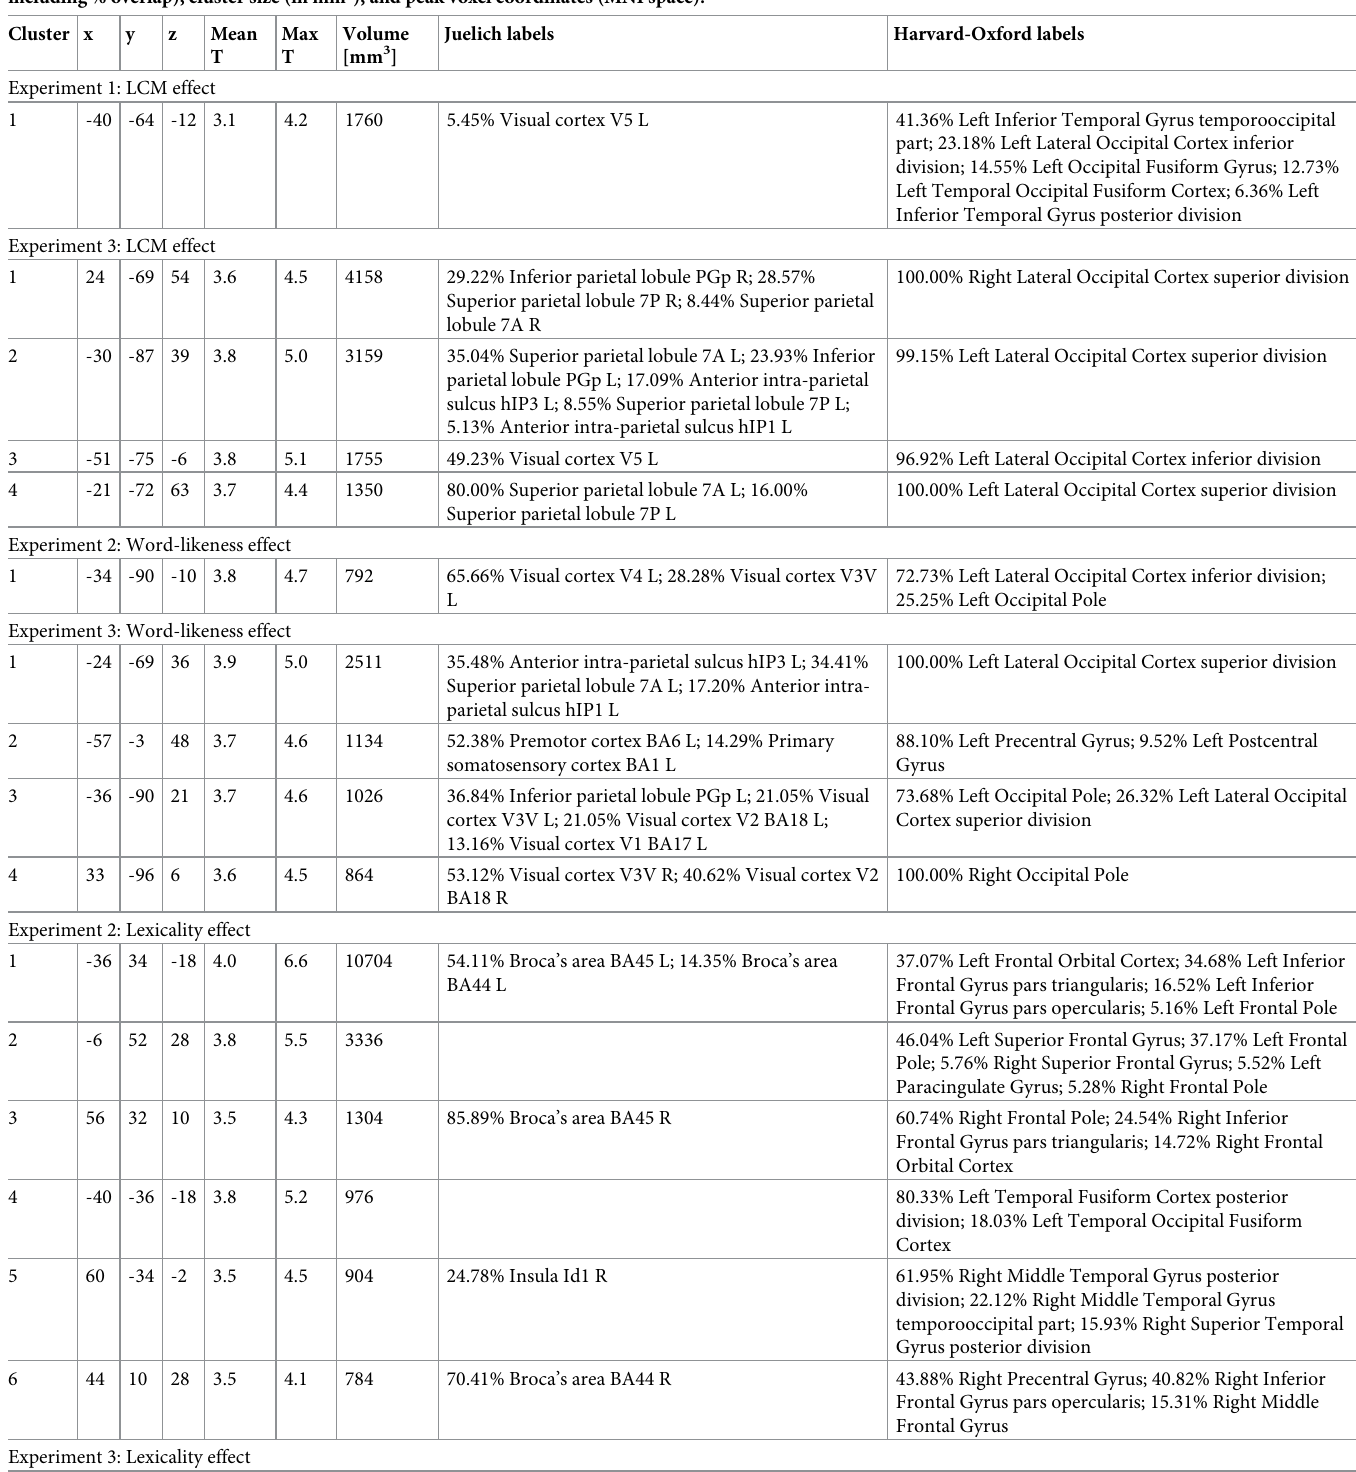
Table 1. Significant activation clusters from the fMRI evaluation with respective anatomical labels (most likely regions from the Juelich and Harvard-Oxford atlases including % overlap), cluster size (in mm 3 ), and peak voxel coordinates (MNI space). Cluster